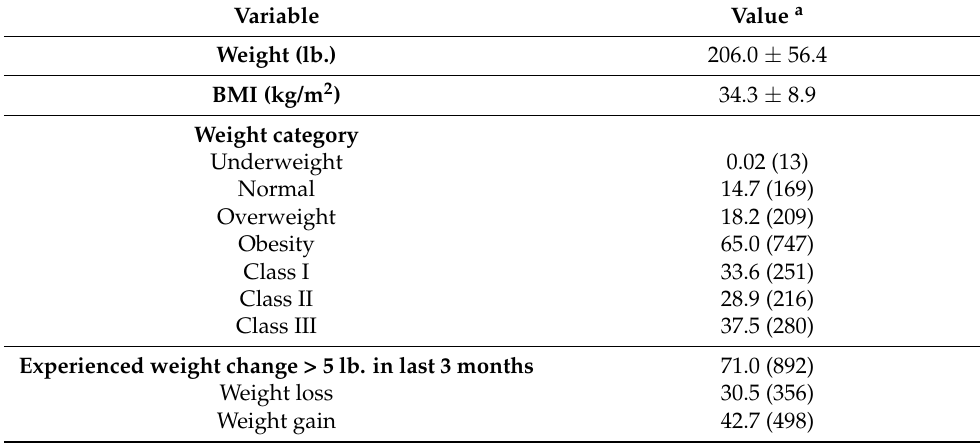
Table 1. Demographic characteristics of women with polycystic ovary